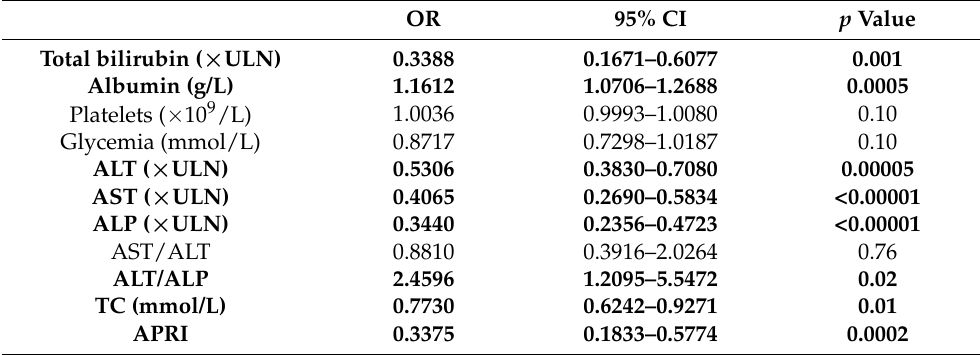
Table 3. Age and sex adjusted associations of pretreatment clinical characteristics of PBC patients with the treatment response after 6 months of UDCA therapy (multiple logistic regression